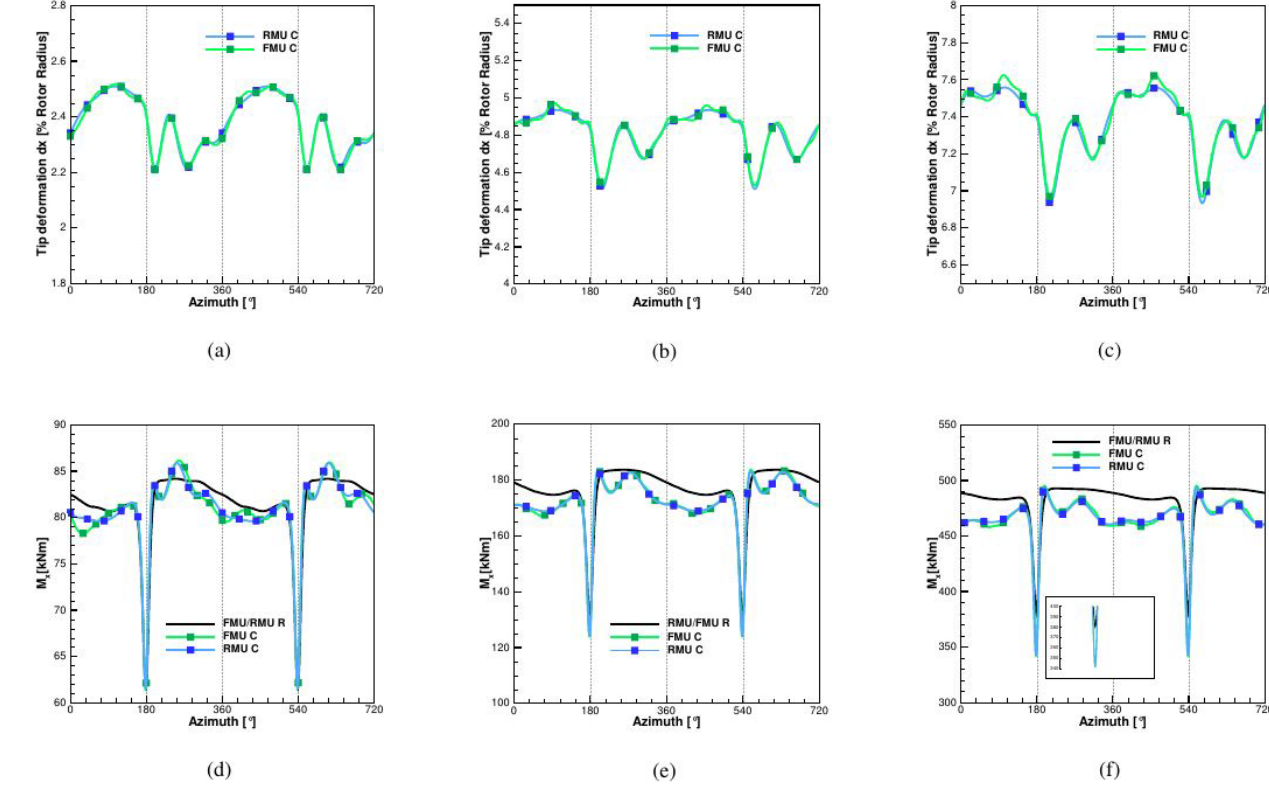
Figure 13. Aeroelastic calculations using BEM as aerodynamic model. Tip deformations in flapwise direction RMU vs. FMU: 6.1ms − 1 in (a) , 9.0ms − 1 in (b) and 13ms − 1 in (c) . Torque ( M x ) generated by one-blade RMU vs. FMU: 6.1ms − 1 in (d) , 9.0ms − 1 in (e) and 13ms − 1 in (f)